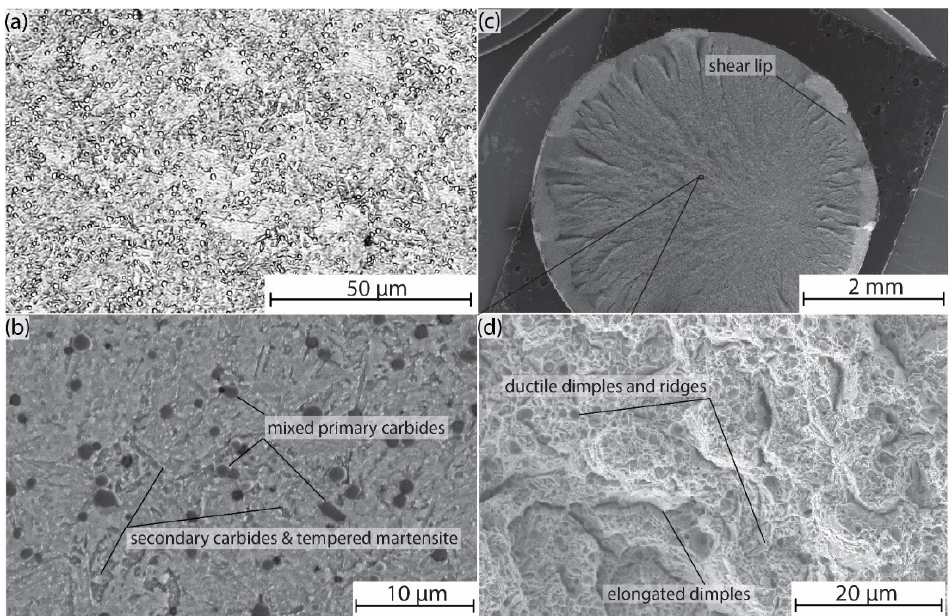
Figure 6. ( a ) Reflected light image of the 700 °C sample. Bright background textures contain tempered martensite which differs from the lath-like as-quenched martensite in the low temperature samples (Figures 3 and 4). ( b ) Backscatter electron image highlighting the occurrence of tempered martensite and secondary carbides. ( c ) Wide-field secondary image of fracture surface highlighting shear lip. ( d ) Small-scale secondary electron image highlighting ductile dimples and ridges showing a ductile mode of failure.